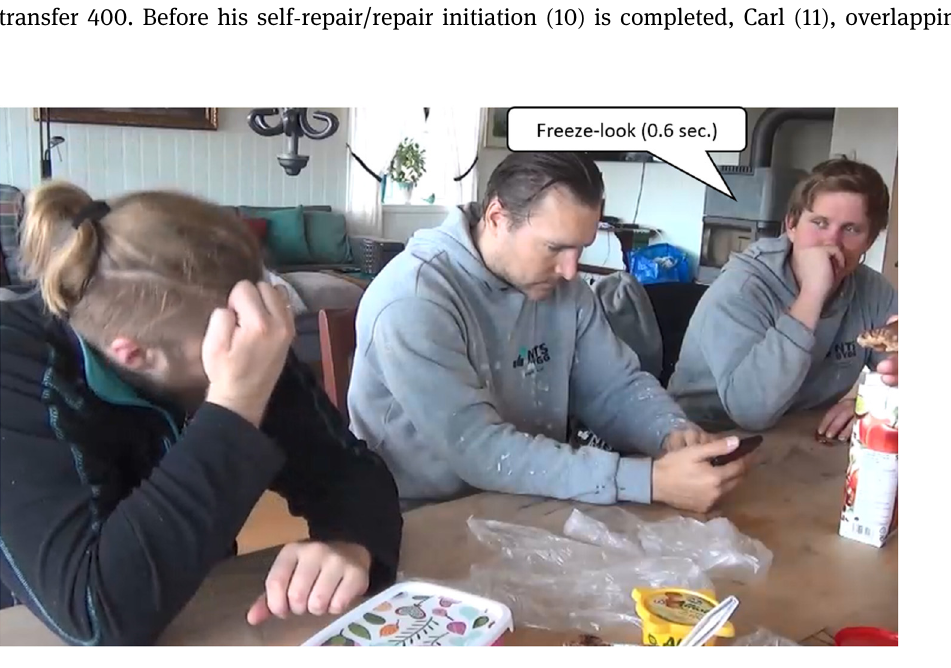
Figure 10: Carl doing a freeze - look response for 0.6